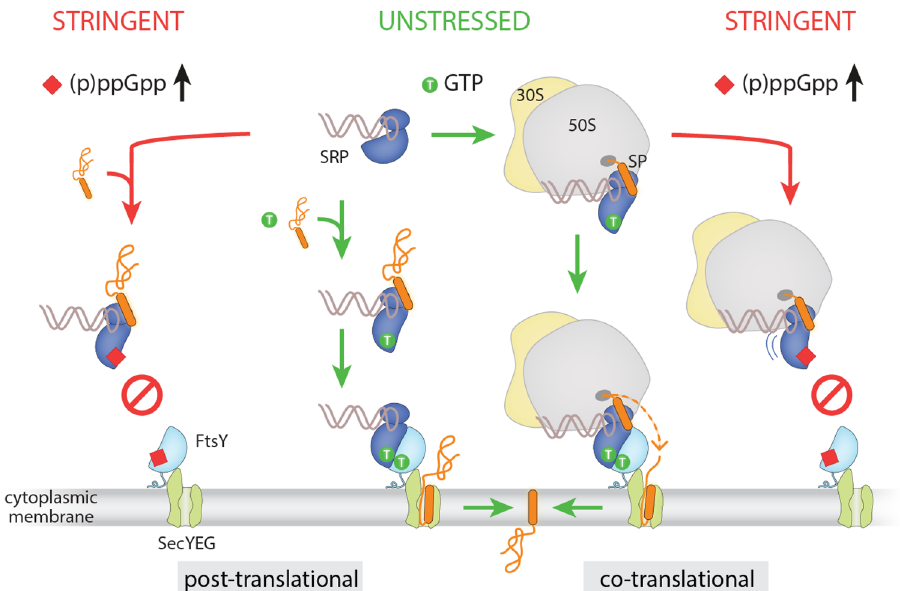
Fig. 6 Schematic summary of the bimodal interference of the alarmones (p)ppGpp with the post- and co-translational SRP-dependent membrane- targeting pathway. In unstressed cells, SRP (Ffh in blue and SRP RNA in gray) usually recognizes a signal peptide (SP, orange) at the ribosomal exit tunnel (co-translational) but can recognize some proteins also after they have been released from the ribosome (post-translational). Binding of a GTP (green) to both SRP and the SRP receptor FtsY (light blue) then allows the formation of the SRP-FtsY-targeting complex, which leads to stimulation of GTP hydrolysis and transfer of the RNC to the SecYEG translocon (light green). In contrast, under stringent stress conditions, (p)ppGpp (red) binds to SRP and prevents formation of the SRP-FtsY-targeting complex through steric hindrance both during post- and co-translation membrane